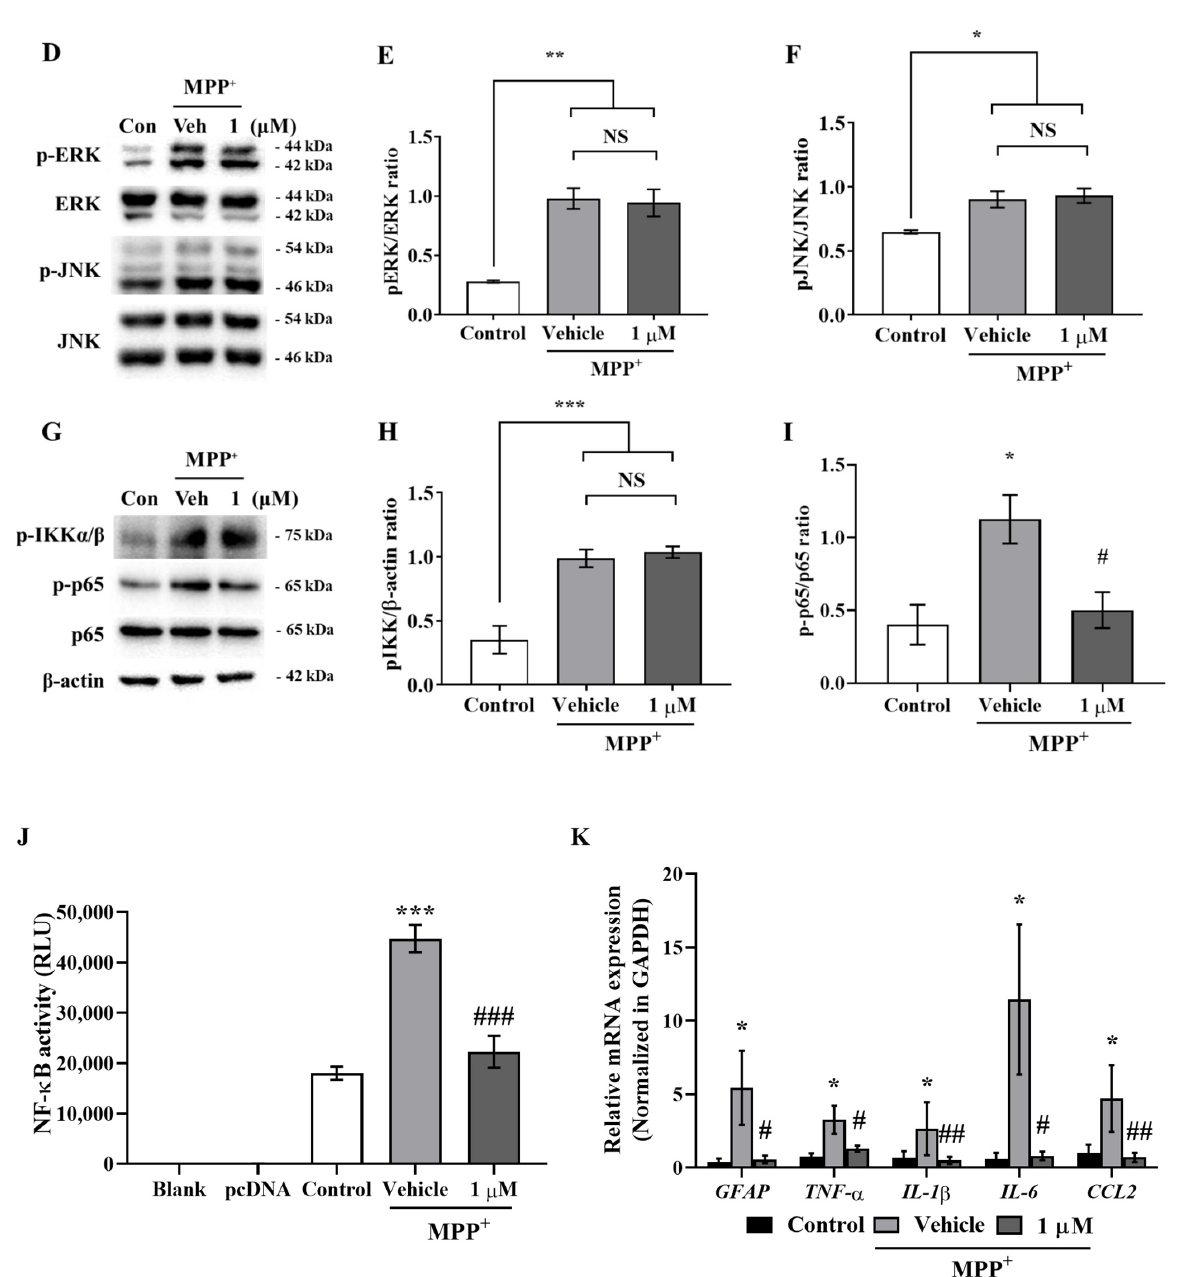
Figure 1. Anti-inflammatory effect of IAGIP on primary astrocytes. ( A ) Representative images showing that IAGIP attenuated GFAP fluorescence intensity (an astrocyte marker); scale bar = 10 µ m. ( B ) Western blot analysis confirmed the inhibitory effect of IAGIP on MPP + -induced glial activation. ( C ) Western blot densitometry results. Three independent experiments were performed ( n = 3). ** p < 0.01 vs. vehicle-treated controls and # p < 0.05 vs. MPP + -treated controls. ( D , G ) Western blot showed that IAGIP reduced p65 phosphorylation without affecting MAPK activation. ( E , F , H , I ) Western blot densitometry results. Three independent experiments were performed ( n = 3). *** p <0.001, ** p <0.01 and * p < 0.05 vs. vehicle-treated controls, and # p < 0.05 vs. MPP + -treated controls. ( J ) Relative luminescence units (RLU) were used to assess NF- κ B promotor activity. Values are means ± SEs ( n = 8). *** p < 0.001 vs. vehicle-treated controls and ### p < 0.001 vs. MPP + -treated controls. ( K ) RT- PCR showed that IAGIP reduced the MPP + -induced mRNA expressions of inflammatory cytokines and CCL2. Values are means ± SEs ( n = 3–4). * p < 0.05 vs. vehicle-treated controls, and ## p < 0.01 and # p < 0.05 vs. MPP + -treated